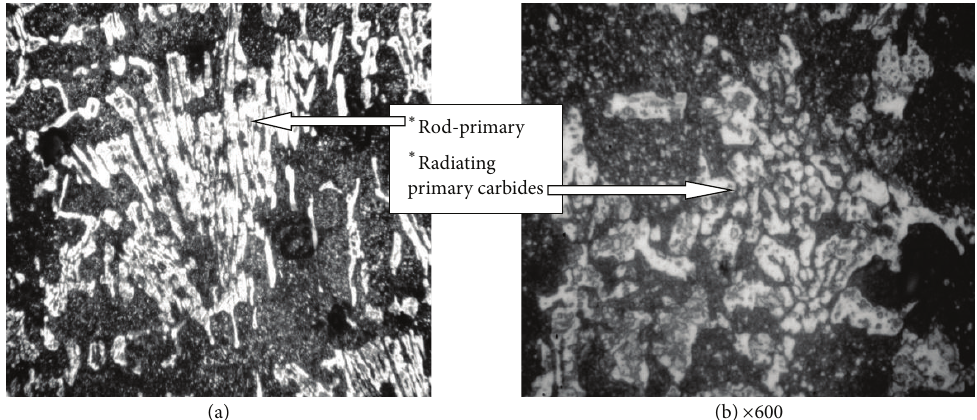
Figure 6: Morphology of rod-like primary carbides and radiating and secondary carbides.